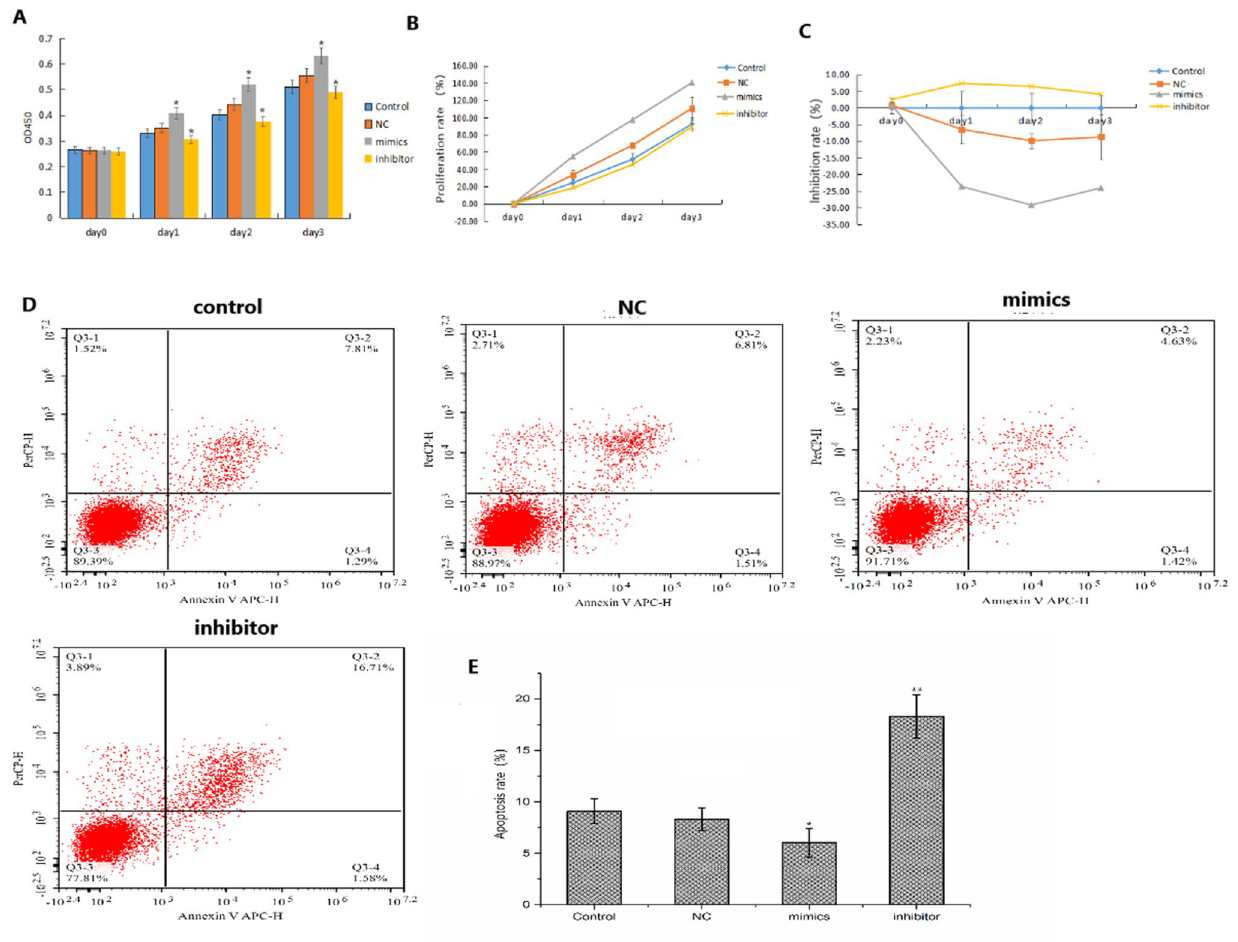
Figure 4. Effect of miR-571 on proliferation and apoptosis of human hepatic stellate cells. ( A – C ) Effect of miR- 571 on proliferation of human hepatic stellate cells. Experimental groups (transfected with miR-571